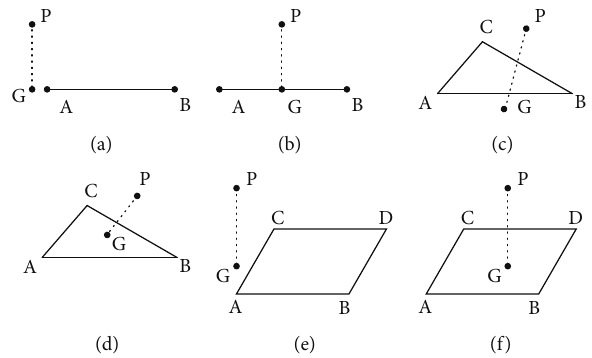
Figure 1: Projection of the point to be interpolated on the target unit: (a, c, and e) projection point outside the unit plane; (b, d, and f) projection point in the unit